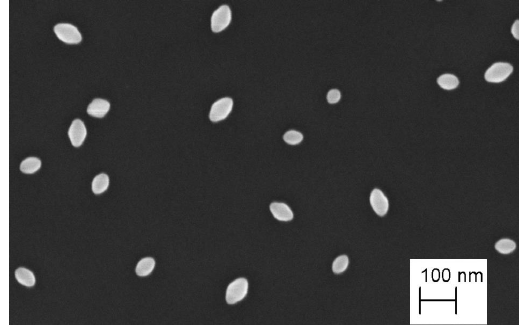
Figure 5. SEM image of nanoscale bipyramidal particles (nPSize03).